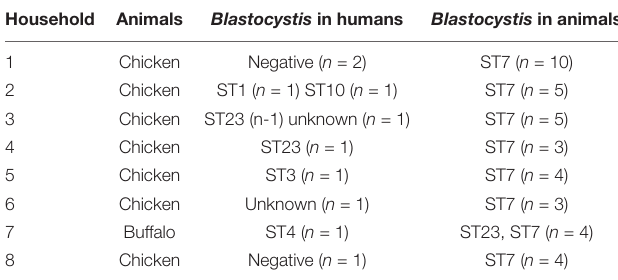
TABLE 3 | Prevalence of Blastocystis in animals and their